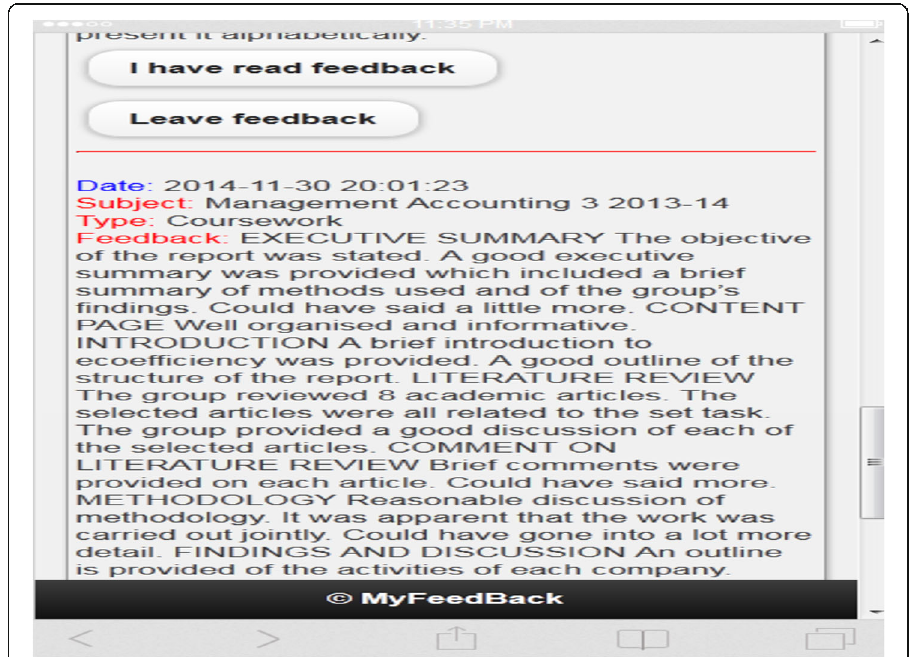
Fig. 1 Example of group feedback on a student ’ s feedback page (Bikanga Ada